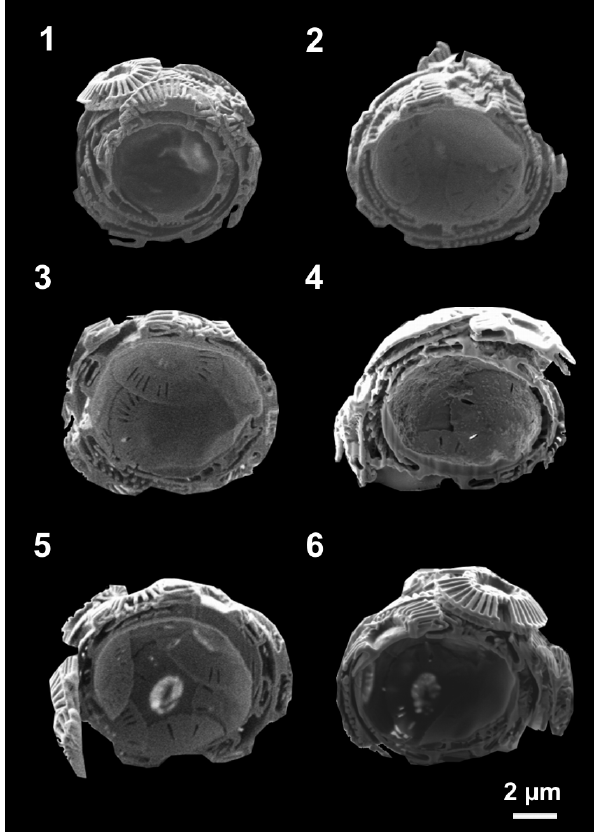
Figure 1. SEM-FIB sectioning sequence of the coccolithophore species E. huxleyi . Image 1 shows the complete coccosphere be- fore slicing, and in 2 the sectioning has just begun. Images 3 and 4 reveal the interlocked layers of coccoliths which make up the coc- cosphere. The coccosphere is formed by three coccolith layers at the upper region and one in the lower region (5). An organic residue of the coccolithophores cell in the upper area of the sphere is visible in 6. In 7 and 8 the last steps of the sectioning can be seen.